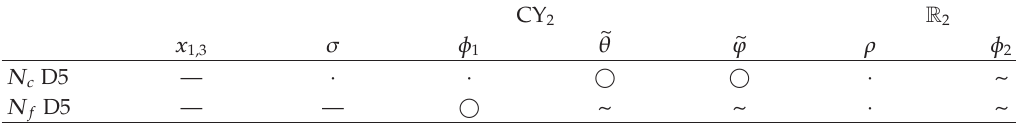
Table 2: A scheme of the set-up: for the brane configuration, a line — means that the brane spans a noncompact dimension, a point · that it is point-like in that direction, a circle (cid:21) that it wraps a compact cycle and ∼ indicates smearing in the direction. Above, it is shown which directions spanned the Calabi- Yau and which the transverse plane before